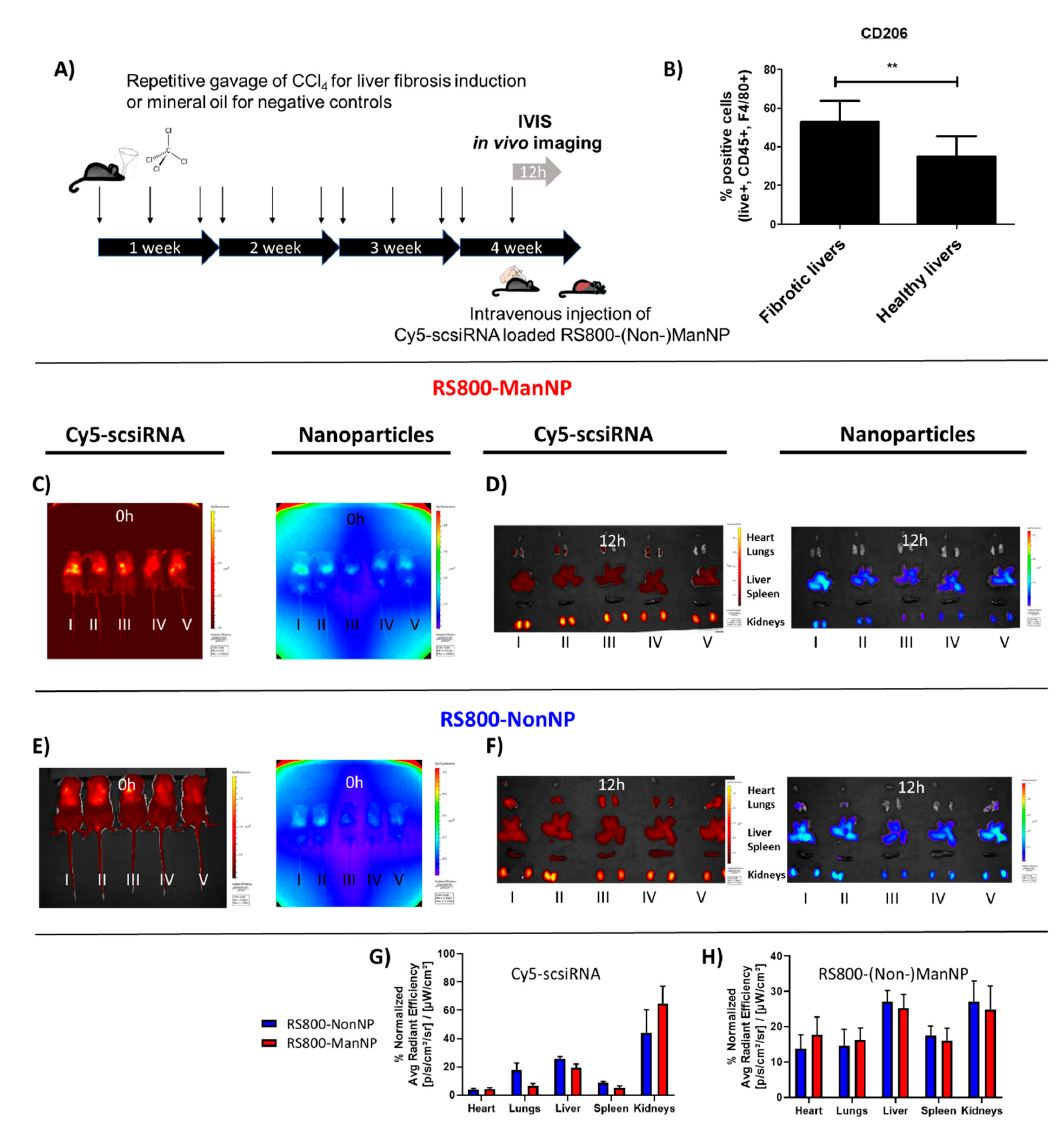
Figure 3. In vivo biodistribution of Cy5 labeled scsiRNA-loaded NIR-labeled RS800-(Non-)ManNP in liver fibrotic mice on the organ level. ( A ) CCl 4 liver fibrosis mouse model: BALB/c mice were gavaged three times weekly with escalating doses of CCl 4 over a period of 3.5 weeks. ( B ) FACS analysis of a liver single cell suspension obtained from healthy and liver fibrotic mice. Profibrotic CD206 + macrophages are significantly higher in fibrotic compared to healthy livers ( n = 5 per group, ** p < 0.001). ( C , E ) NIR in vivo imaging of RS800-ManNP / NonNP loaded with Cy5-scsiRNA directly after injection ( t = 0 h): Carrier and siRNA accumulated primarily in the fibrotic livers. ( D , F ) Corresponding ex vivo imaging of Cy5-scsiRNA-loaded RS800-NonNP in organs harvested 12 h after IV injection (organs of mice treated with PBS alone served as autofluorescence controls): both particles and their cargo accumulated primarily in the livers (Figure S1). ( G , H ) Quantification of ex vivo organ fluorescence as shown in extracted organs above. Both siRNA cargo and particles e ffi ciently accumulated in the liver, while biodegraded particle fragments and siRNA were excreted via the